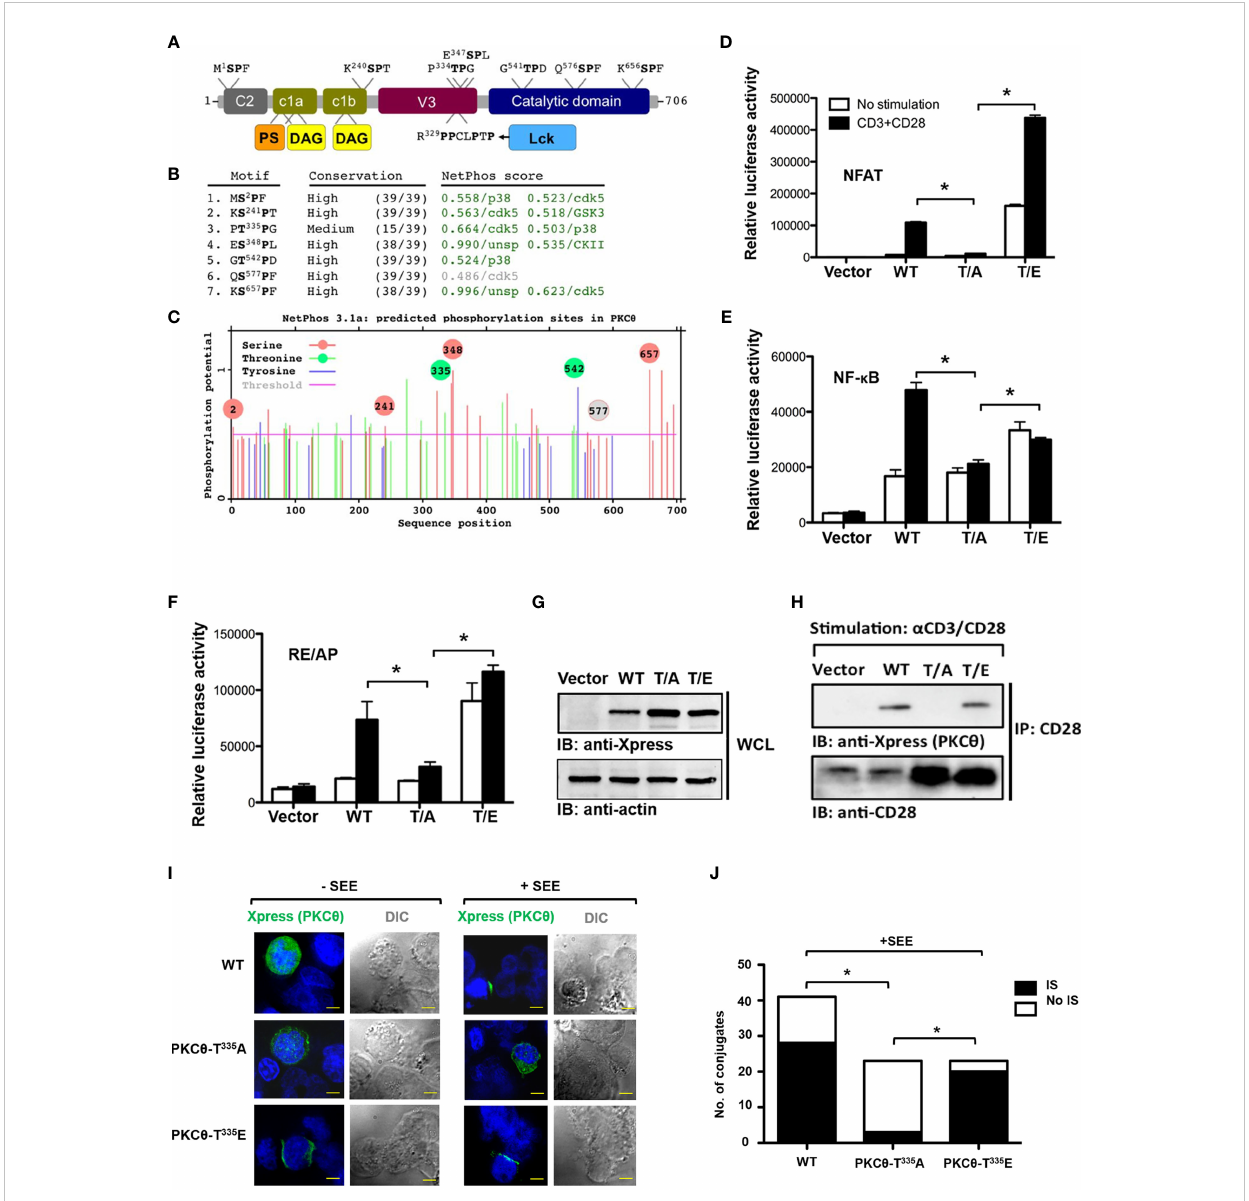
FIGURE 1 Phosphorylation of Thr 335 -Pro is required for PKC q activation, binding to CD28, and IS localization. (A) The modular structure of PKC q and some of its potential functional motifs. PKC q possesses an N-terminal regulatory region with several conserved functional domains and a C-terminal catalytic region. A recently described polyproline-rich region within the V3 domain mediates CD28 binding, via Lck, as an intermediate protein, and controls PKC q recruitment to the center of the immunological synapse. Short independent sequences containing Ser/Thr-Pro motif in human PKC q are indicated above the fi gure representing the PKC q protein backbone. Phosphorylation of each of these Ser/Thr residues can potentially serve as Pin1 binding/isomerization sites. (B) Human PKC q protein sequence analysis, using NetPhos 3.1, predicted six out of seven Ser/Thr-Pro motifs as in vivo phosphorylation sites (score values >0.5, green color), and made kinase-speci fi c predictions for the majority of these sites. Unsp=unspeci fi ed kinase. (C) A diagram showing sequence positions of all NetPhos 3.1-predicted phosphorylation sites on PKC q . Phosphorylation sites within Ser/Thr-Pro motifs are indicated by a circle (Ser-red; Thr-green)(grey-below the threshold value), including positions of the putative phosphoresidues. (D – G) Luciferase activity in Jurkat E6.1 T cells transfected with expression vectors for Xpress-tagged wild-type [WT (T 335 P)], mutant PKC q [T/A, A 335 P; T/E, E 335 P] or an empty vector, together with a luciferase reporter for NFAT (D) , NF- k B (E) , or the CD28 response element RE/AP (F) , and b - Galactosidase ( b -Gal) reporter, post-stimulation with anti-CD3 plus anti-CD28 mAbs. Results are presented as relative units (RLU) of luciferase to b - Gal activities. * P <0.05 (one-way ANOVA). Whole cell lysate immunoblot analysis of PKC q expression probed with anti-Xpress, and anti- b -actin, as a protein loading control (G) . (H) Analysis of PKC q coimmunoprecipitation with CD28 from lysates of Jurkat E6.1 T cells transfected with the indicated Xpress-tagged PKC q vectors or an empty vector, and stimulated for 5 min with anti-CD3 plus anti-CD28 mAbs. Immunoblot (IB), immunoprecipitates (IP). (I) Immuno fl uorescence imaging of Jurkat E6.1 T cells that were transfected with an expression vector for Xpress-tagged wild-type or mutant PKC q and incubated at a ratio of 1:1 with Raji B cells pulsed with Staphylococcus enterotoxin E (SEE) for 5 min. After fi xation, conjugates were stained with mouse anti-Xpress plus a secondary Alexa fl uor 488-coupled Ab (AF488) and counterstained with DAPI (blue, nuclear staining). Original magni fi cation, x 60, Scale bar, 2 m m. Data are representative of three experiments. DIC, Differential interference contrast. (J) Quanti fi cation of the localization of PKC q in (IS) or outside (No IS) the immunological synapse and cSMAC in T cell-APC conjugates as